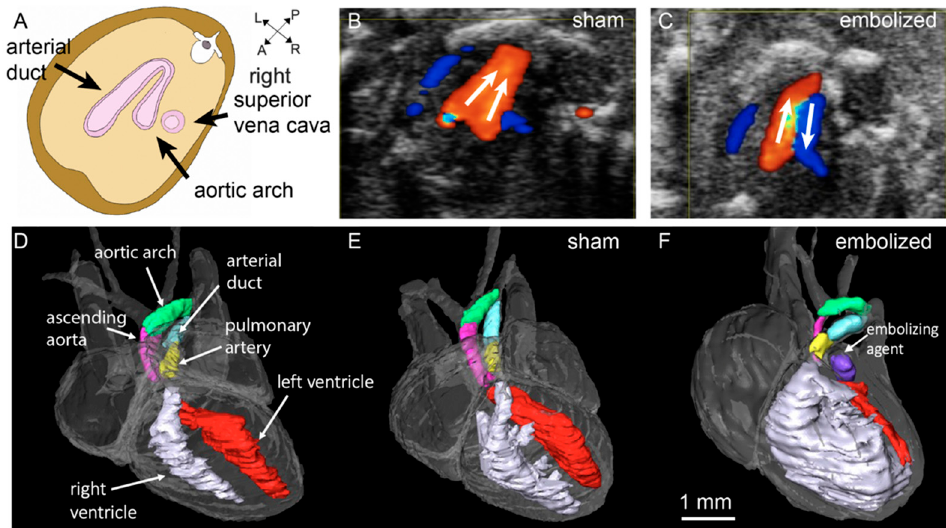
Figure 1. Aortic arch blood flow and left heart structural abnormalities observed at gestational term in hypoplastic left heart syndrome (HLHS) mice. Referring to the anatomical reference ( A ), blood flow through the aortic arch was antegrade in the sham ( B ) (needle advancement into the left atrium but without any embolization) and retrograde in the embolized fetus ( C ), as seen in color-flow Doppler ultrasound. High-resolution three-dimensional magnetic resonance imaging (MRI) of the fetal heart ( D ) in which the major heart structures are manually colored. Comparing a sham ( E ) and embolized fetus ( F ), the left ventricle was non-apex-forming, and the chamber volume was greatly reduced by embolization of the left atrium. The caliber of the ascending aorta vessel was also smaller compared to the pulmonary trunk in the embolized fetus. L: left; R: right; A: anterior; P: posterior. Figure modified from [31] under a CC-BY 4.0 license.